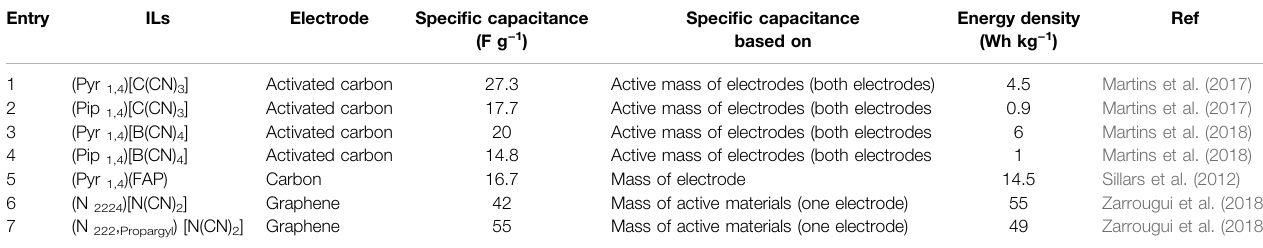
TABLE 4 | Summary of SC performance of pyrrolidinium and piperidinium